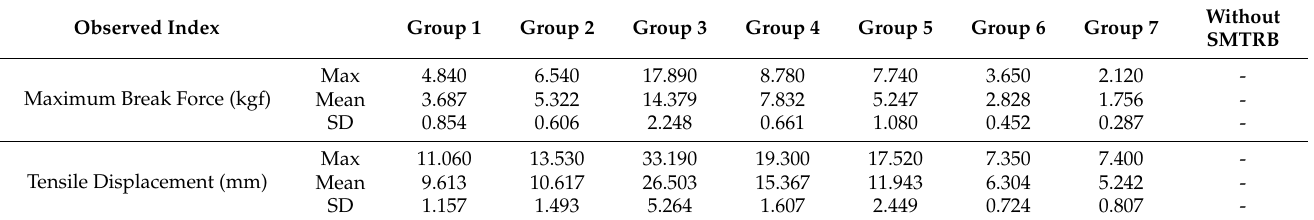
Figure 7. ( a ) The rupture of the SMTRBs in each group. ( b ) The distribution of von Mises stress on the surgical mask tension release bands in each group. Table 4. The maximum break force, the tensile displacement of the SMTRB, and the stiffness as measured by the tensile testing machine. The pressure measured by the sensor array system is also